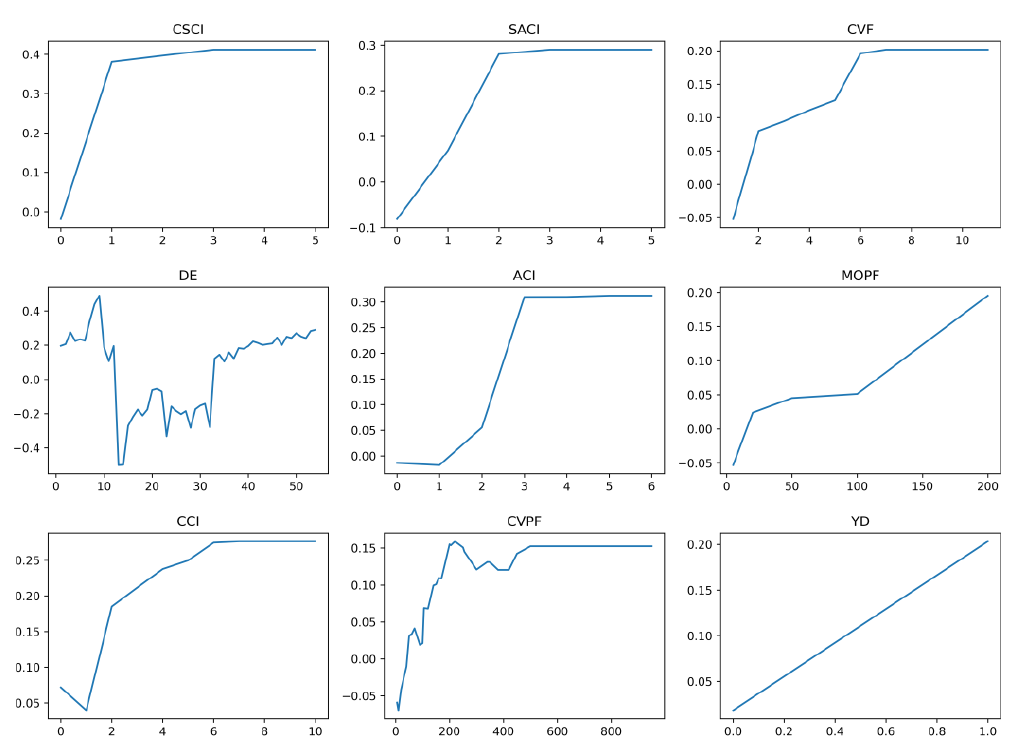
Figure 8. Partial dependence of top 9 important features on risk pattern.